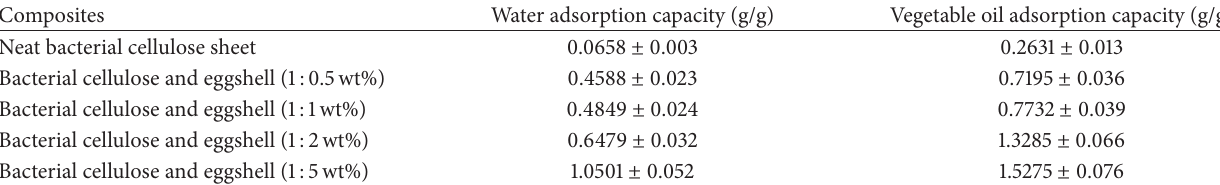
Table 3: Water adsorption capacity and vegetable oil adsorption capacity of bacterial cellulose and eggshell composite membrane.